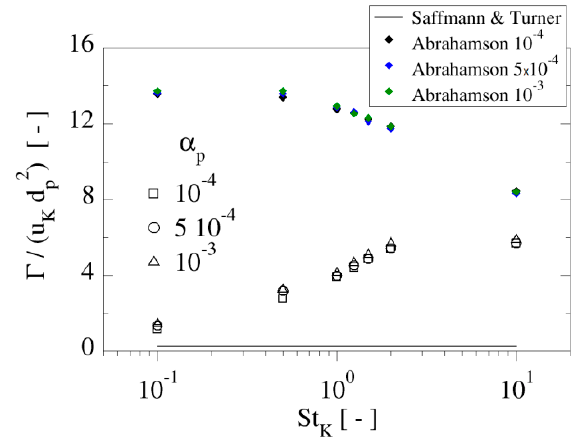
Figure 11. Collision kernel, normalised by the Kolmogorov velocity, and the square of particle diameter, obtained by the present simulations as a function of the particle Stokes number and for the three average particle volume fractions. The Saffman and Turner [44] and Abrahamson [45] kernels for colliding particles are also shown for comparison.